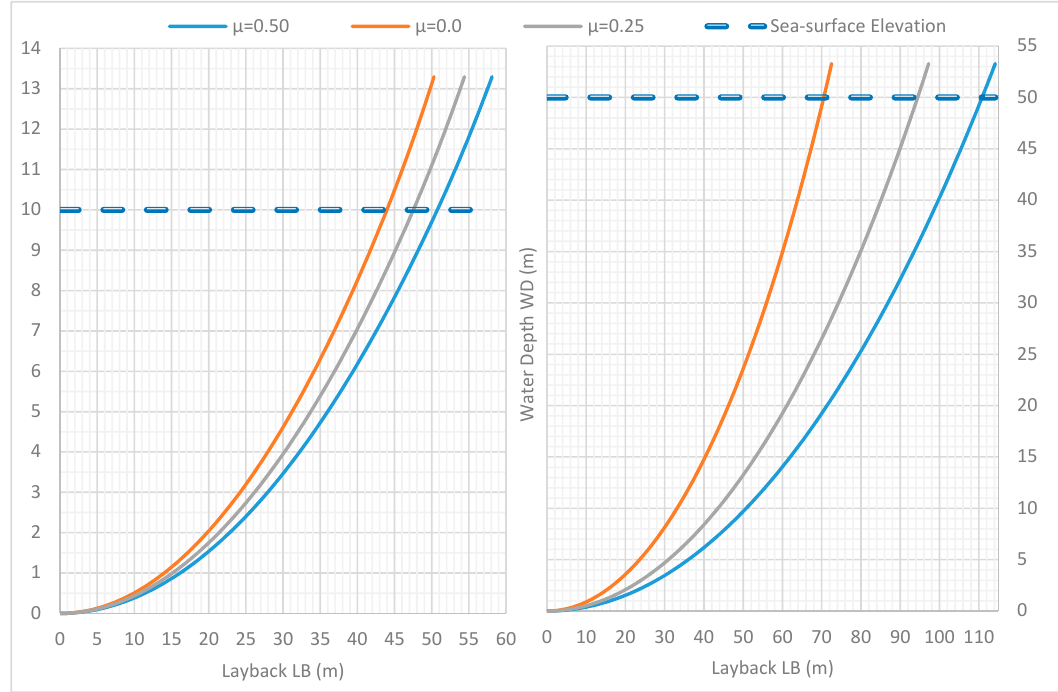
Figure 22. Cable configuration for CS1 assuming different friction coefficients at 10 m and 50 m water depth.